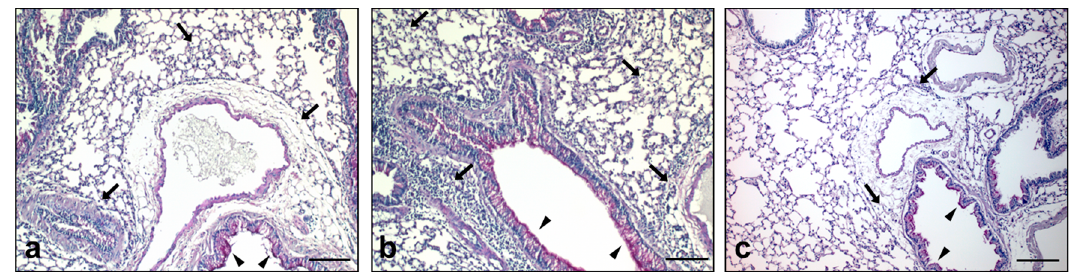
Figure 3. Ag50-PVP NPs exert dose-dependent effects in vivo . Histological analysis of representative lung sections of S mice 5 days after SUP ( a ), 50 µg Ag50-PVP ( b ) or 1 µg Ag50-PVP ( c ) and ovalbumin (OVA) challenge. Periodic acid Schiff (PAS) staining: inflammatory infiltrate (arrows) and mucus hypersecretion (arrowheads). Scale bar: 100 µm.